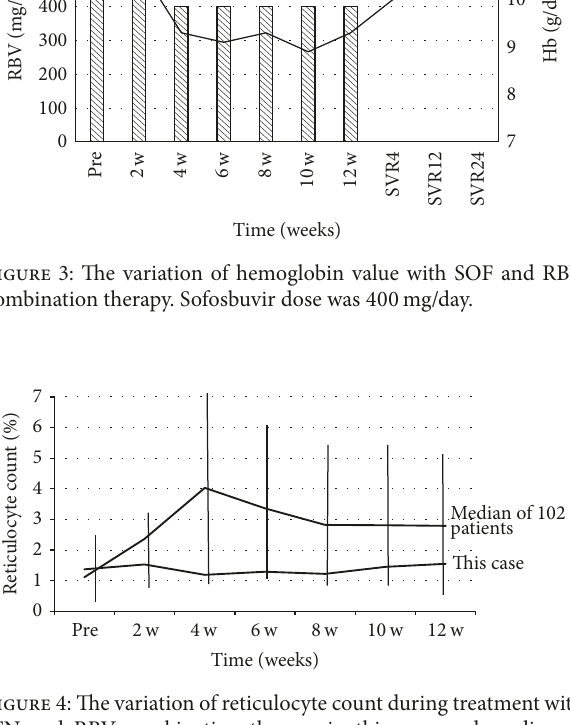
did not respond to the stimuli; it was very low during this treatment in this case (Figure